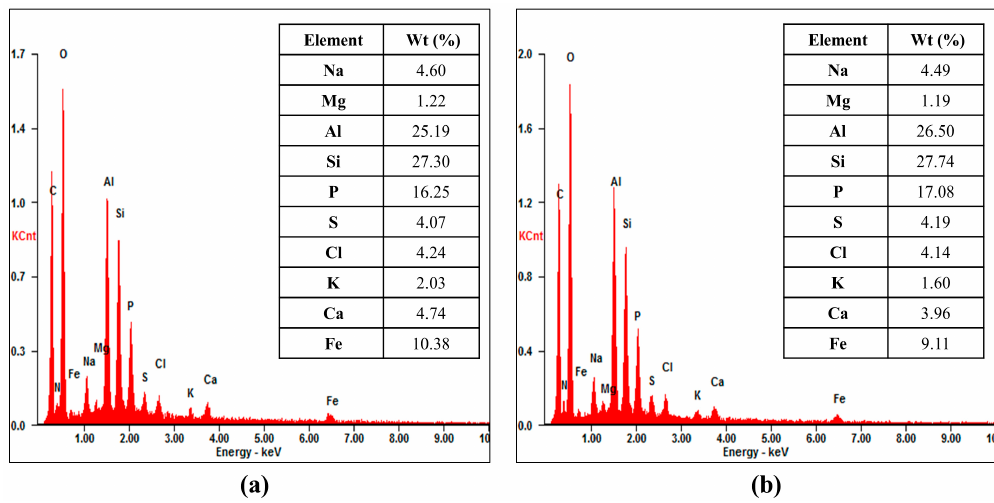
Figure 13. EDX chemical precipitations on the fouled RO membrane: ( a ) FEn; ( b ) FLR.